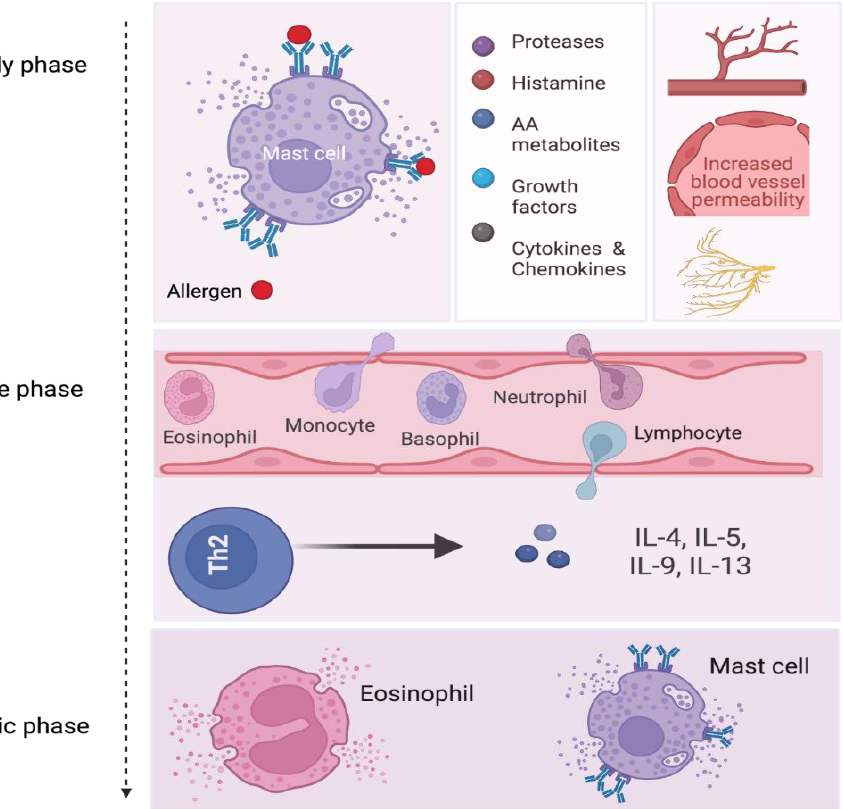
Figure 1. MCs’ role in the pathophysiology of AR. During the early phase of allergic inflammation, activated MCs secrete their preformed and de novo synthesized mediators, leading to nasal itching (by stimulating nerve endings), angiogenesis, vasodilation, and an increase in vascular permeability, then leading to nasal congestion and rhinorrhea . Cytokines and chemokines produced and released during the early phase induce the recruitment of various inflammatory cells to the site of inflammation. These cells secrete inflammatory mediators, further enhancing the inflammation and promoting its prolongation. MCs and eosinophils are predominantly found during the late and chronic phases of inflammation when resolution fails to occur. Figure 1 created using